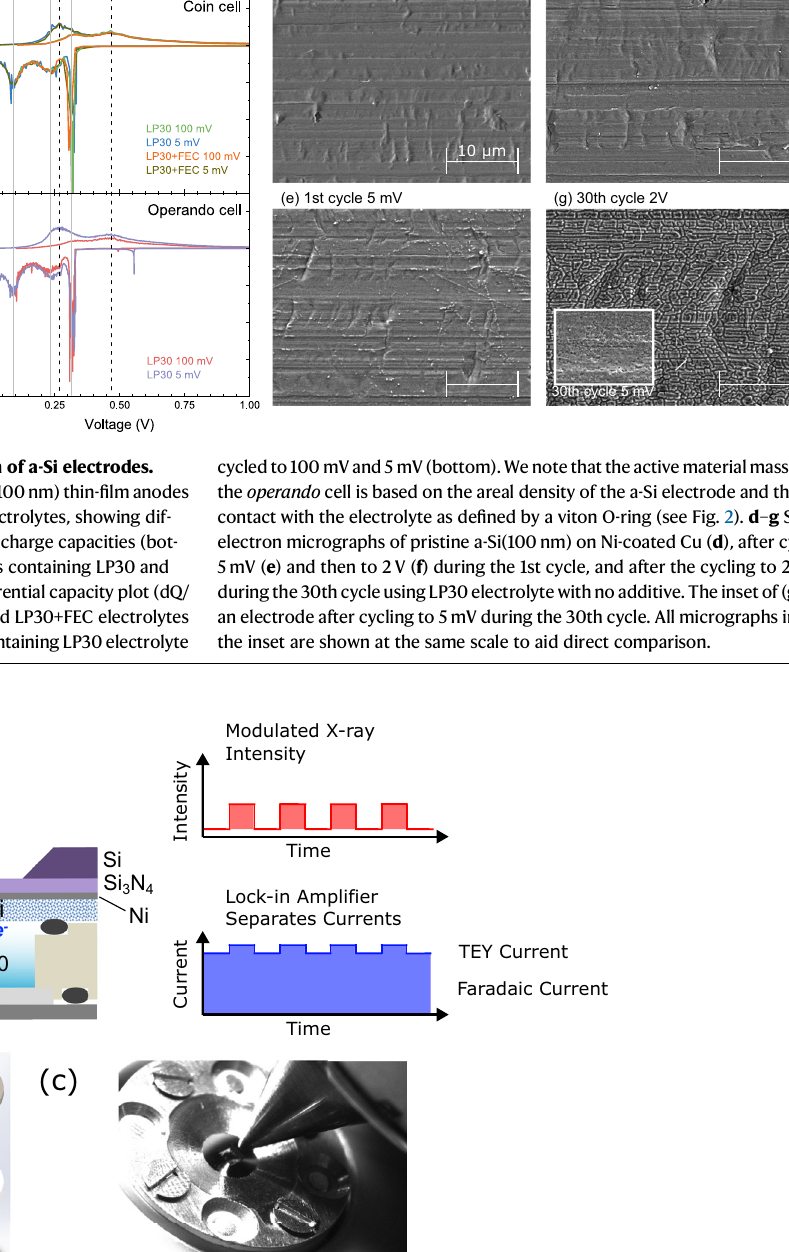
currentgeneratedunderX-rayillumination,employingabeam-chopperandlock-in ampli fi er set-up to separate faradaic and TEY currents. b Deconstructed 3D cell design, showing the positions of the O-rings, fl anges, membrane, Li electrode and separator. c Photograph of operando cell in the experimental setup.